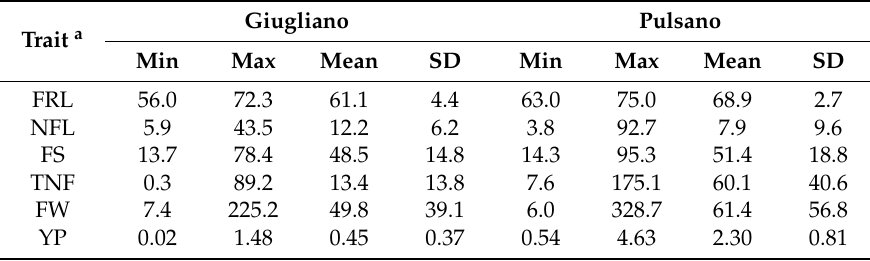
Table 1. Phenotypic variation of the six traits analysed in the tomato landraces collection. Mean (Mean), standard deviation (SD), minimum (Min) and, maximum (Max) values related to the two experimental fields (Giugliano and Pulsano) are reported.